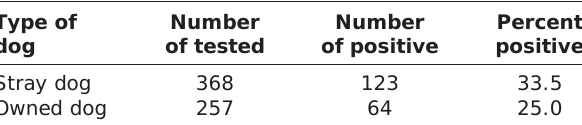
Table-1: Seroprevalence of T. gondii in stray and owned dogs from Grenada. Type of